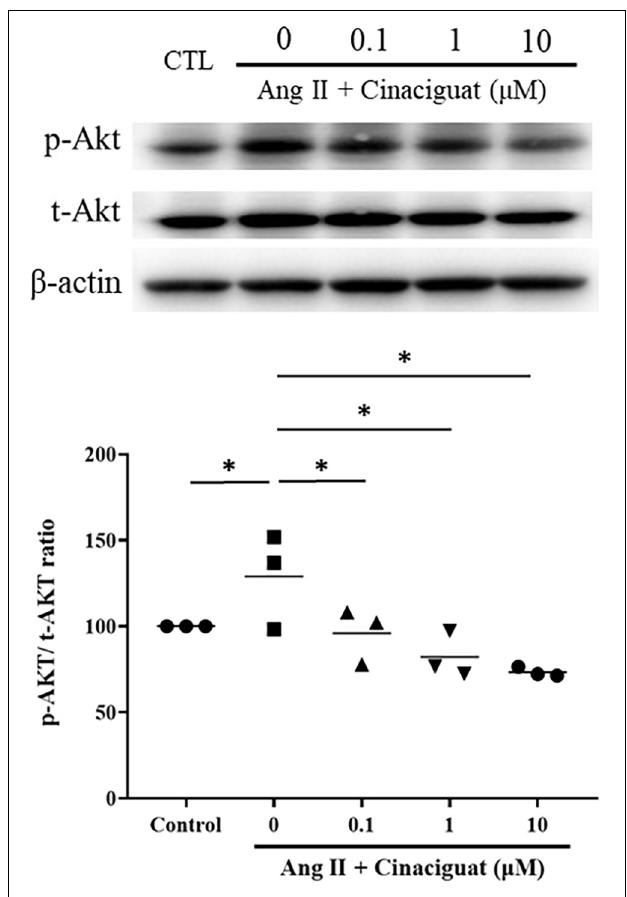
FIGURE 8 | Cinaciguat-inhibited activation of Akt signaling as shown by Western blotting. Ang II activated Akt signaling significantly. Cinaciguat down-regulated Ang II-induced Akt activation dose-dependently. Values are presented by the dot plot with the mean. N = 3. One-way ANOVA P < 0.0001; * P < 0.05 vs. Ang II